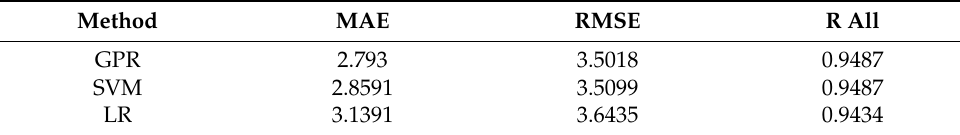
Table 4. Results of regressions methods.